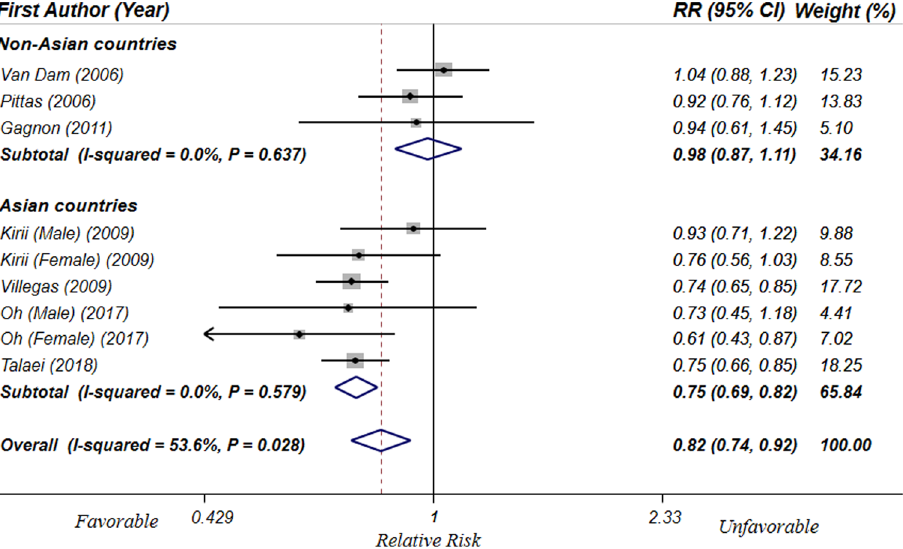
Figure 2. Forest plots of the association of highest vs. lowest level of dietary Ca intake and T2DM in prospective cohort studies with representative adult populations, stratified by study location (Asia vs. Non-Asia).